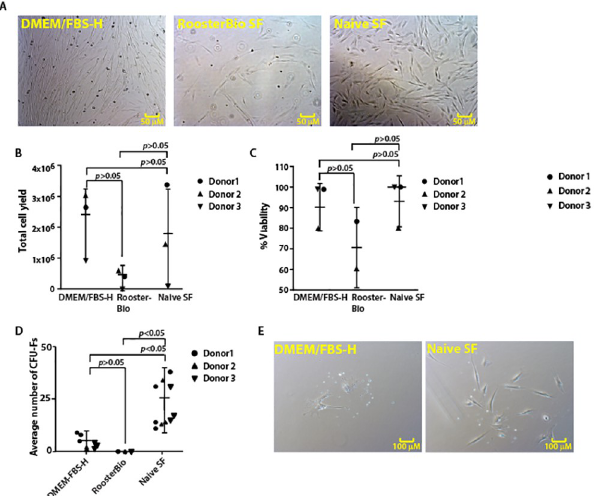
Fig 2. Na ï ve serum-free medium supports canine Ad-MSC growth. A . Images of the cell morphologies of canine Ad-MSCs cultured in indicated medium prior to trypsinization. B . Total cell yield of canine Ad-MSCs cultured in indicated medium. Means of two replicates for each donor are shown. C . Viability of canine Ad-MSCs cultured in different media. Note: Viability could not be determined for donor 3 in commercial serum-free medium. Means of two replicates for each donor are shown. D . CFU-F formation by canine Ad-MSCs in different media. Means of three replicates for each donor are shown. E . Colony morphology of canine Ad-MSCs cultured in indicated medium.